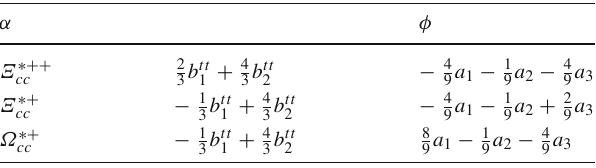
Table7 ThecoefficientsofthetreediagramsinFig.1,whichcontribute to the O ( p 1 ) and O ( p 3 ) magnetic moments